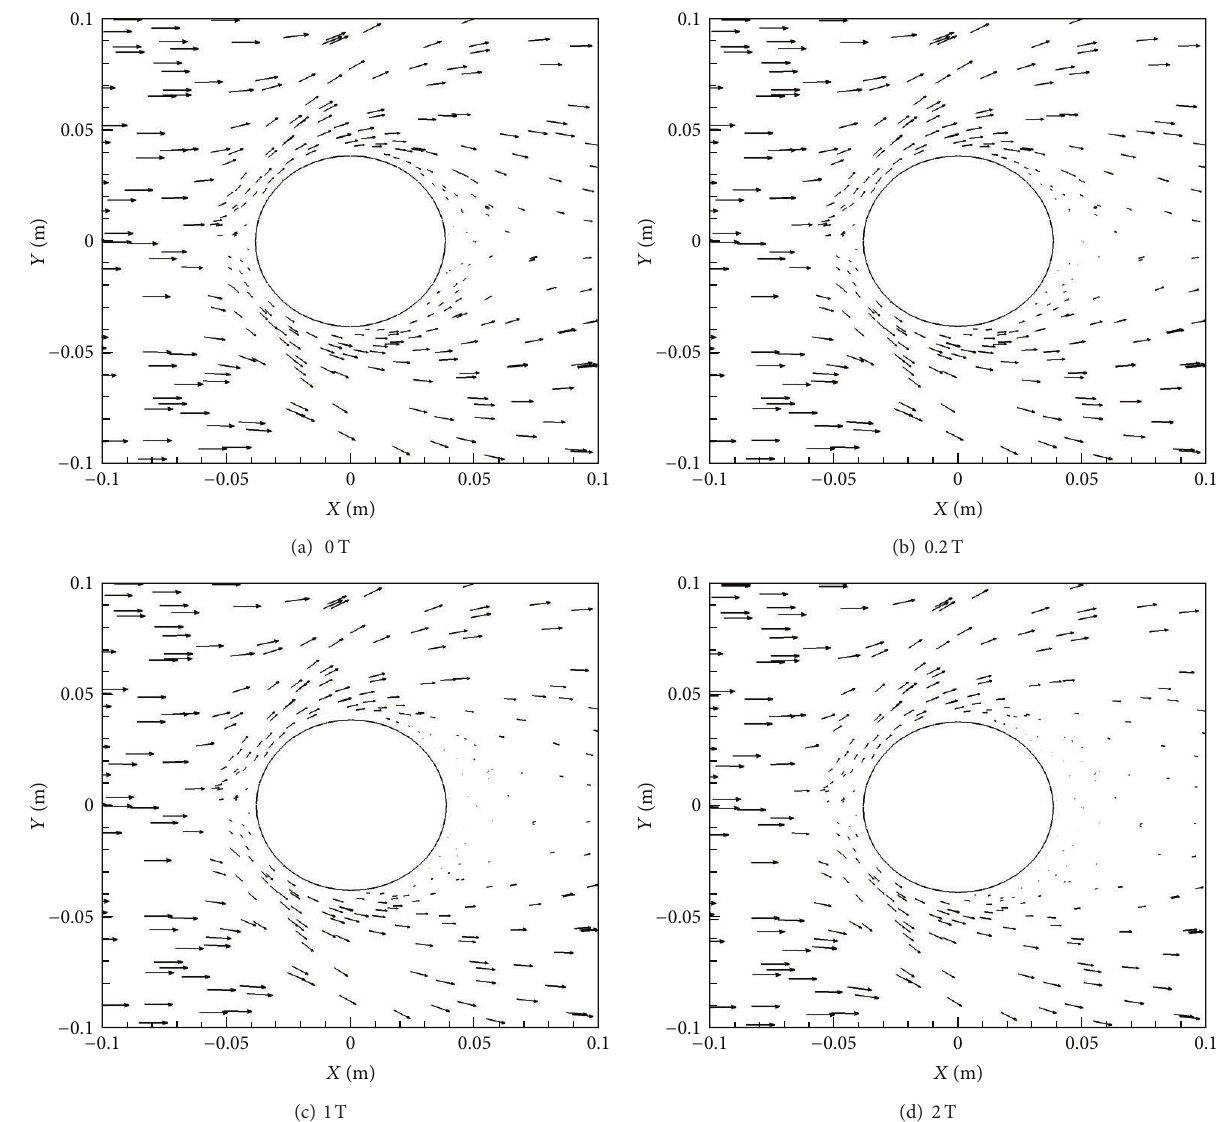
Figure 5: Velocity vectors for various 𝐵 max with 𝑋